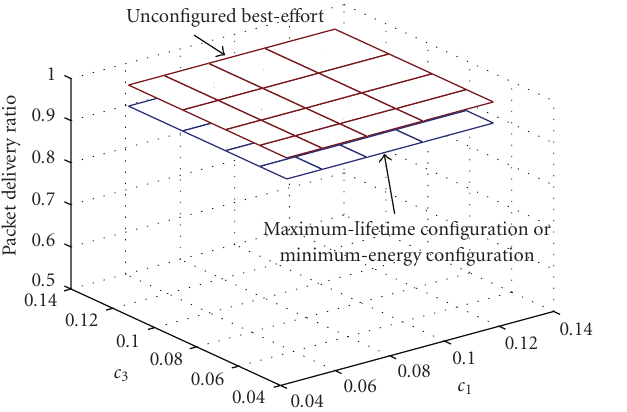
Figure 3: Path lifetime with the maximum-lifetime configura- tion, minimum-energy configuration, and unconfigured best-e ff ort strategies for a 3-hop path ( P req = 0 . 95, N = 11, p max = 0 .